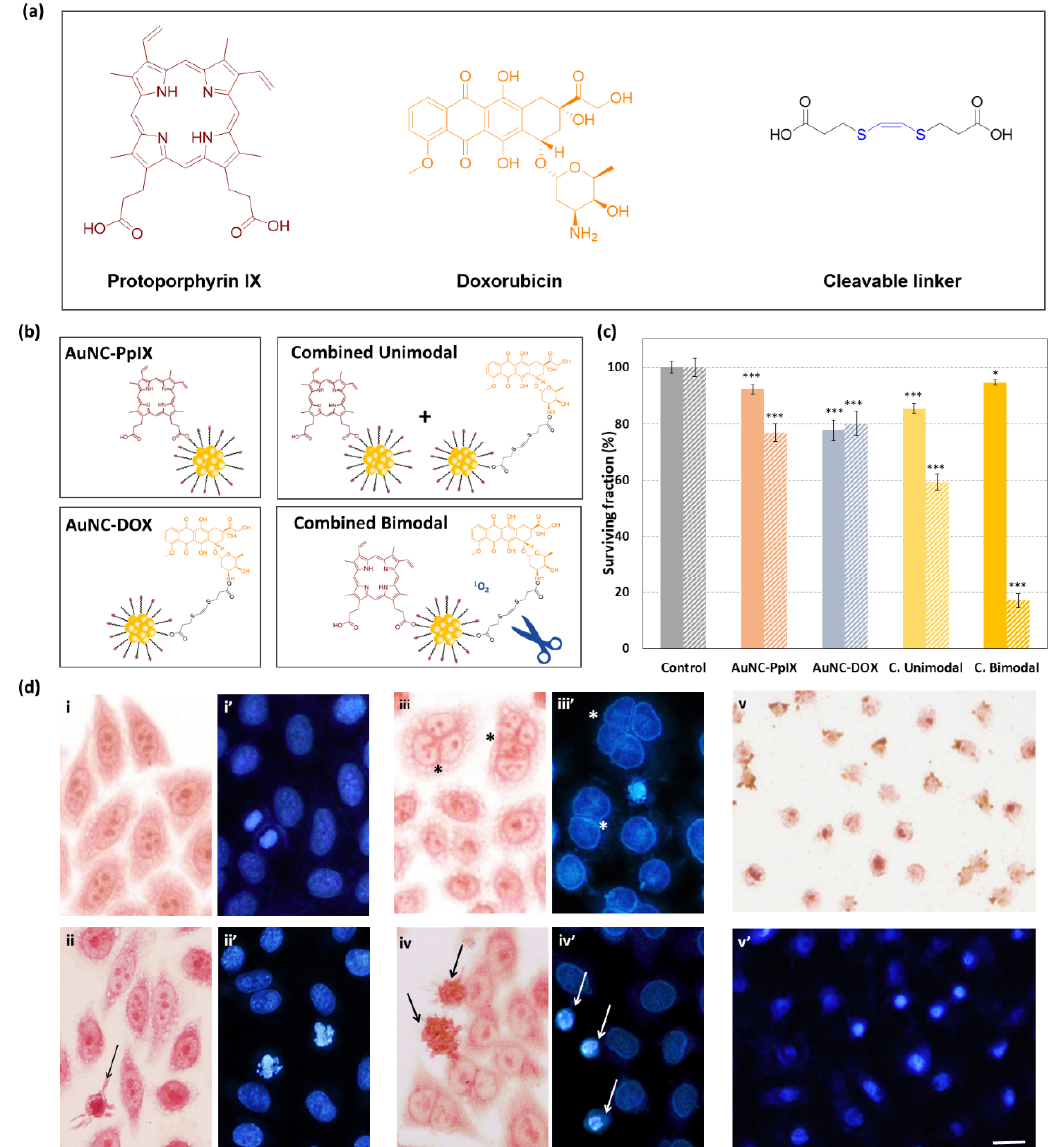
Figure 2. AuNC-PpIX-DOX treatment synergistically enhances cell death of HeLa cells. ( a ) Scheme of compounds used in different treatments; ( b ) Nanoconjugates and treatments; ( c ) MTT viability assay 48h after individual and combined treatments in dark conditions (plain bars) and after 2.4 J/cm 2 of exposure to red light (striped bars). Data correspond to mean ± S.D. values from at least three independent experiments. Statistically significant differences are labeled as * p < 0.01 and *** p < 0.001; ( d ) Neutral red ( i – v ) and H-33258 ( i’ – v’ ) staining on HeLa cells 48 h after treatments. ( i , i’ ) Control cells, ( ii , ii’ ) AuNC-PpIX treatment, ( iii , iii’ ) AuNC-DOX treatment, ( iv , iv’ ) combined unimodal treatment, and ( v , v ’) combined bimodal treatment. Multinucleated cells (*) and cells with apoptotic morphology (arrows) were found. Scale bar: 10 μm in all images.